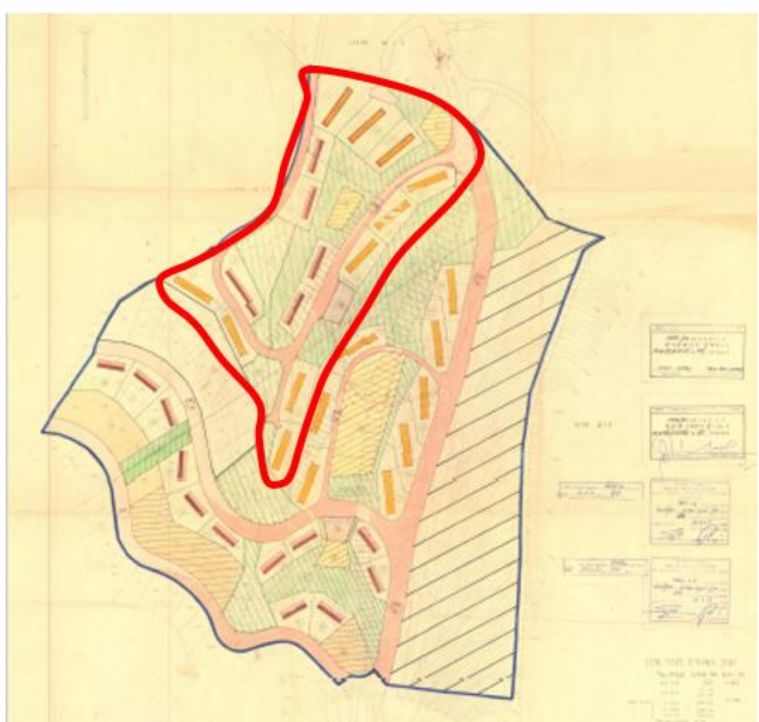
Figure 3. The original neighborhood plan. In red, the area earmarked for renewal. Source: the Israeli “Available Planning” website (The Planning Administration, Ministry of Interior) archive.